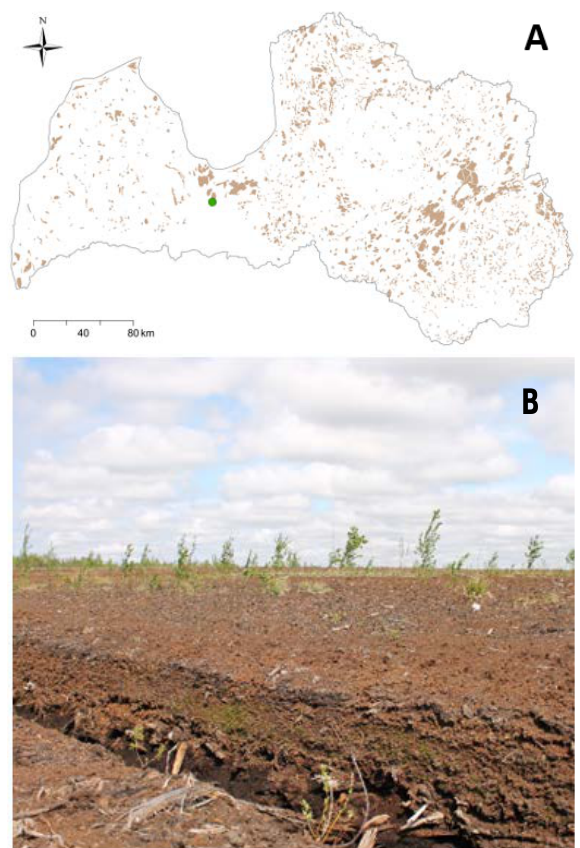
Figure 1. The experimental site “Kaigu purvs”, Latvia. (A) Location of the experimental site (marked with a green dot) with a background map of border line of Latvia (grey lines), peat deposits or peat industrial sediments (coloured in